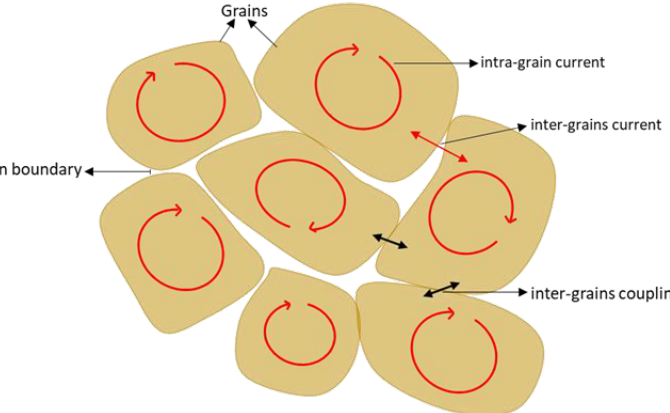
Figure 6. A general view of a polycrystalline sample illustrates the inter-grain current, intra-grain current, and inter-grain coupling.